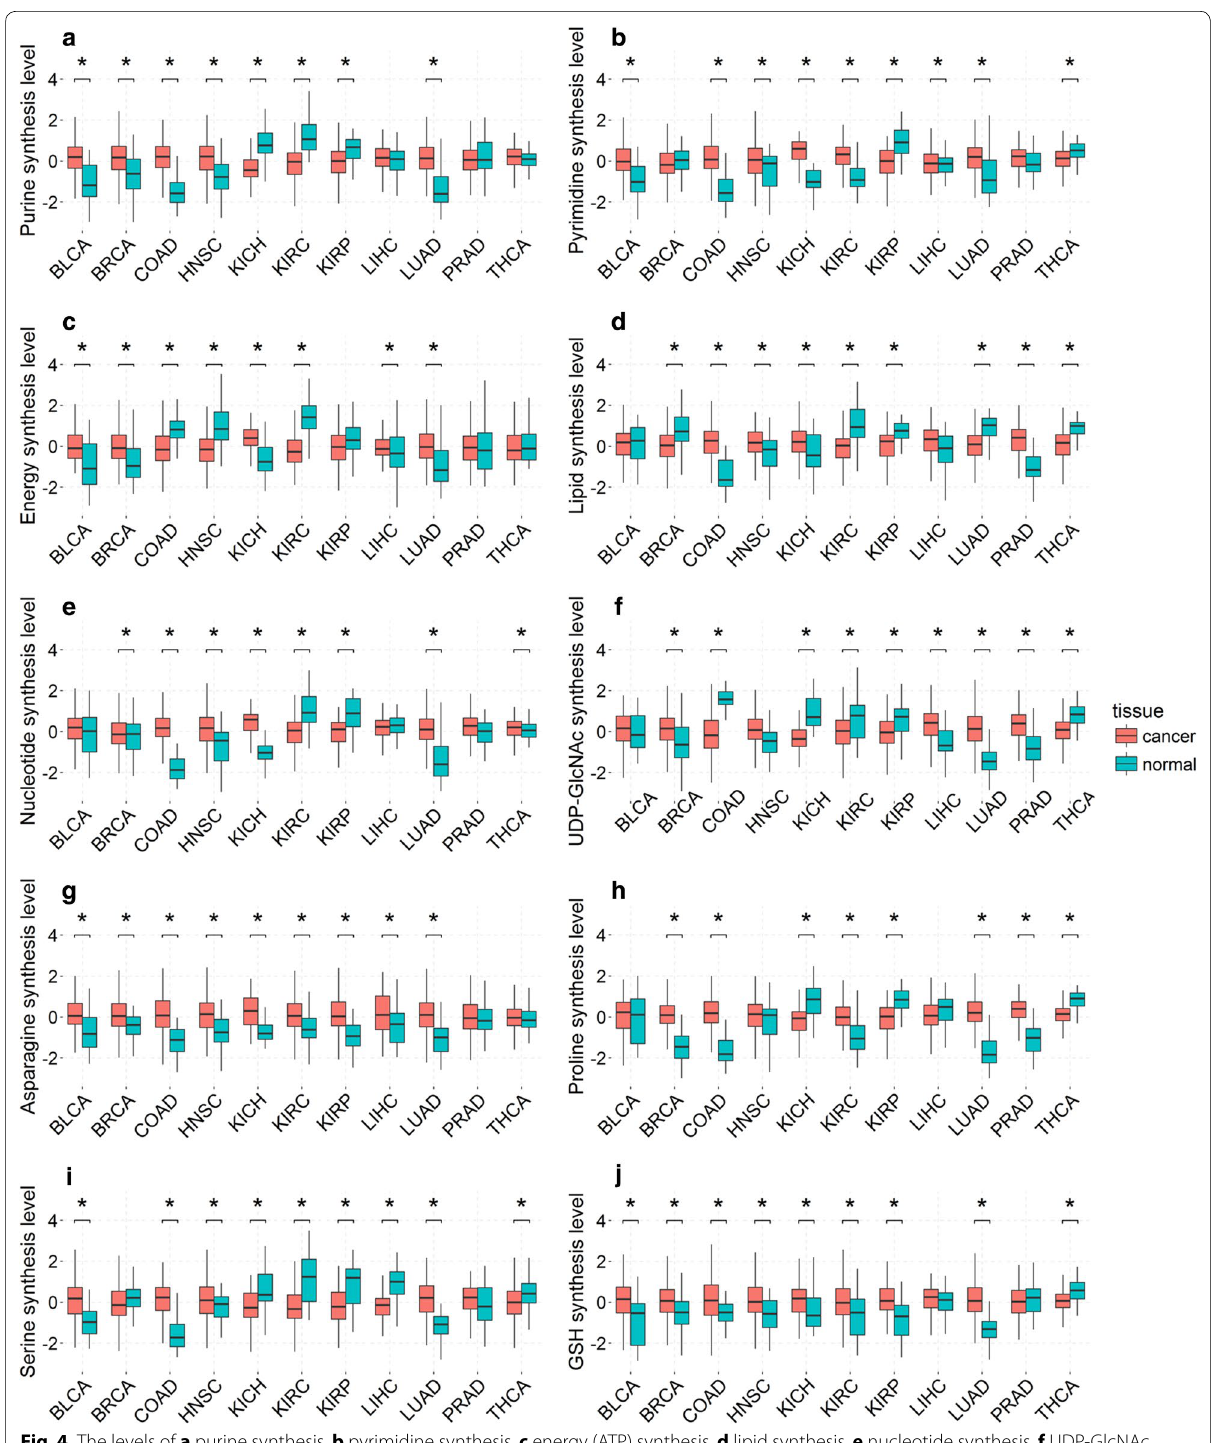
Fig. 4 The levels of a purine synthesis, b pyrimidine synthesis, c energy (ATP) synthesis, d lipid synthesis, e nucleotide synthesis, f UDP-GlcNAc synthesis, g asparagine synthesis, h proline synthesis, i serine synthesis, and j GSH synthesis in cancer (red) versus control tissues (blue) in 11 types of cancer. In each panel, the X axis represents the names of the 11 cancer types, the Y axis is for the expression level, and * represents the P value no more than 0.05 analyzed with the t test. BLCA, bladder urothelial carcinoma; BRCA, breast invasive carcinoma; COAD, colon adenocarcinoma; HNSC, head and neck squamous cell carcinoma; KICH, kidney chromophobe; KIRC, kidney renal clear cell carcinoma; KIRP, kidney renal papillary cell carcinoma; LIHC, liver hepatocellular carcinoma; LUAD, lung adenocarcinoma; PRAD, prostate adenocarcinoma; THCA, thyroid